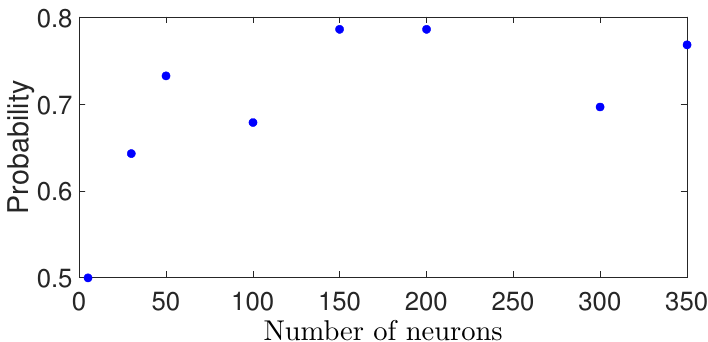
Figure 13. Probability of closed-loop stability vs. RNN width.